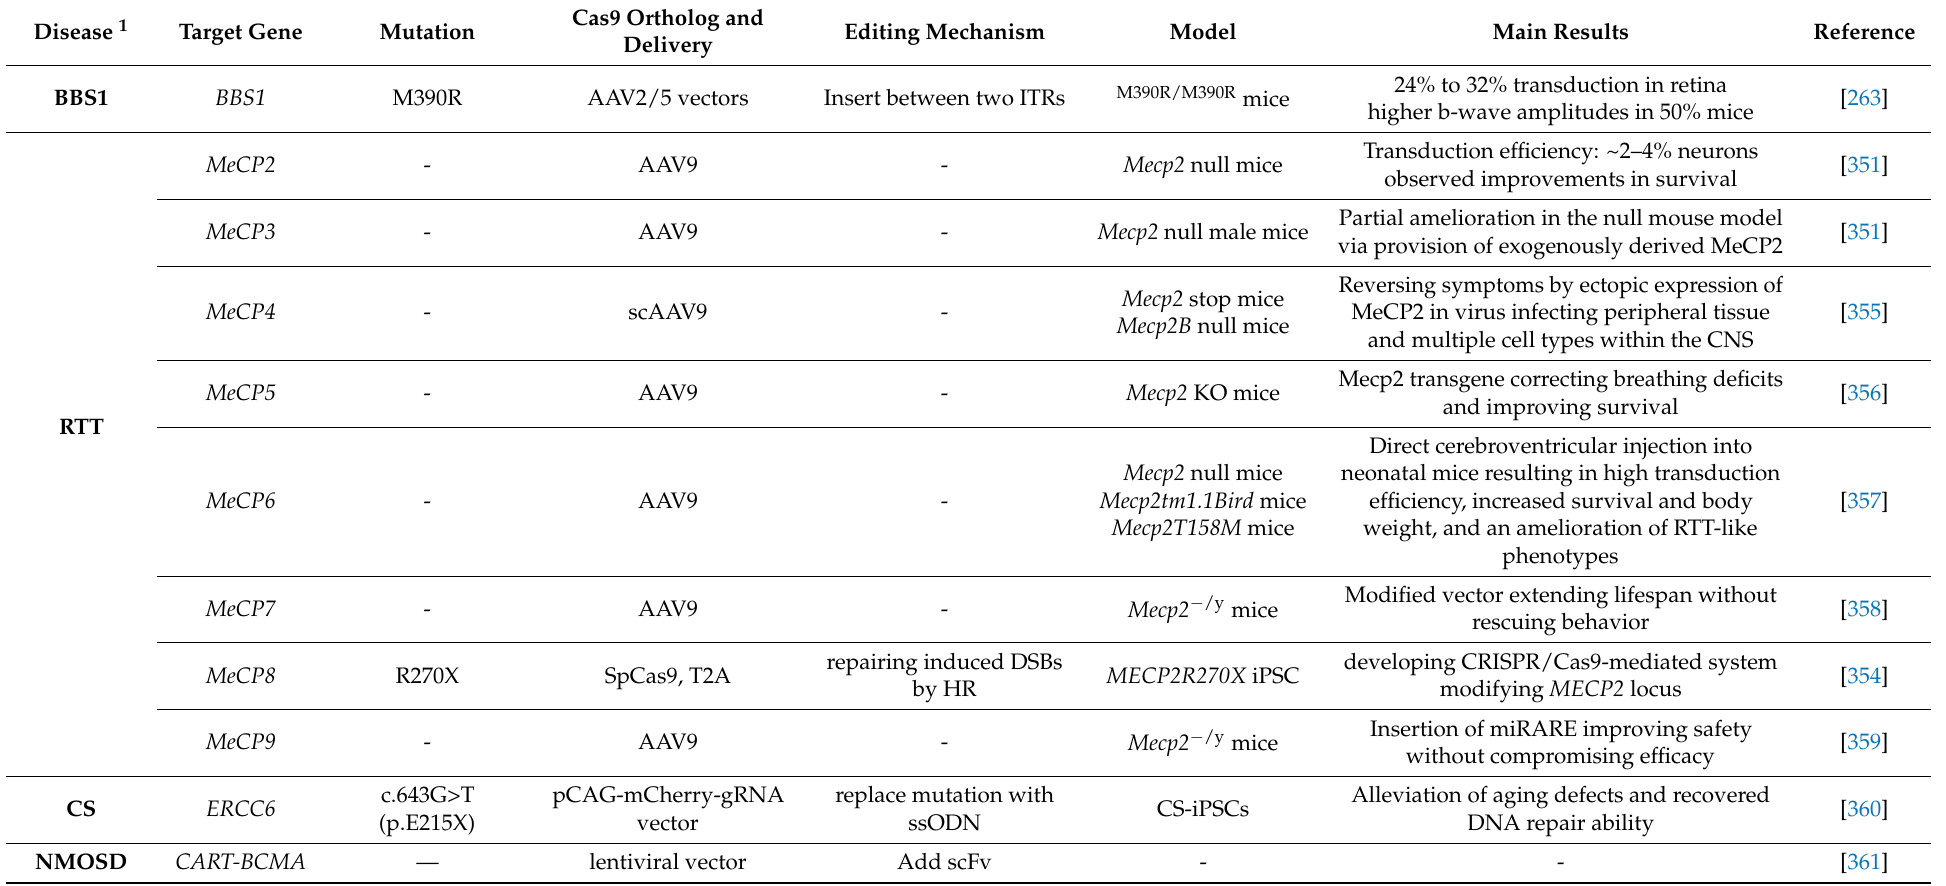
Table 5. Research in Gene